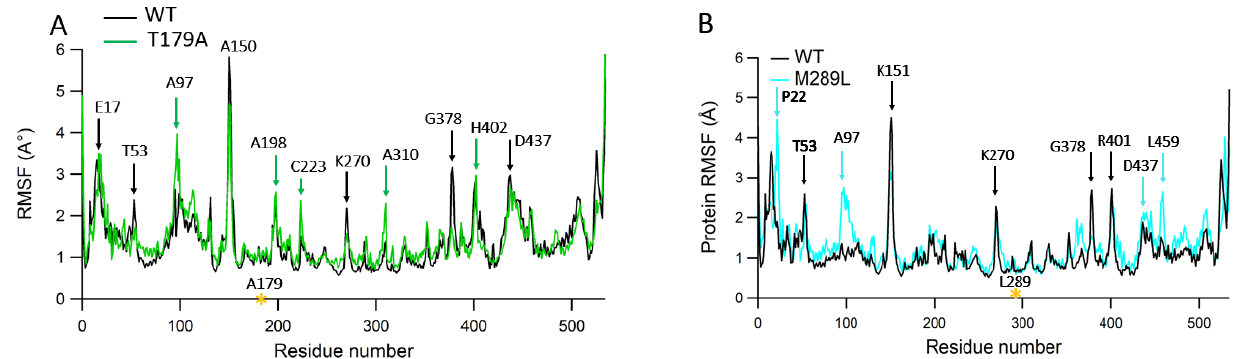
Figure 7. The RMSF values comparison between WT and T179A ( A ) and WT and M289L ( B ). The RMSF values of the C α atoms for residues in WT (black), T179A (green), and M289L (blue) are shown with the mutant positions are noted by red asterisks.